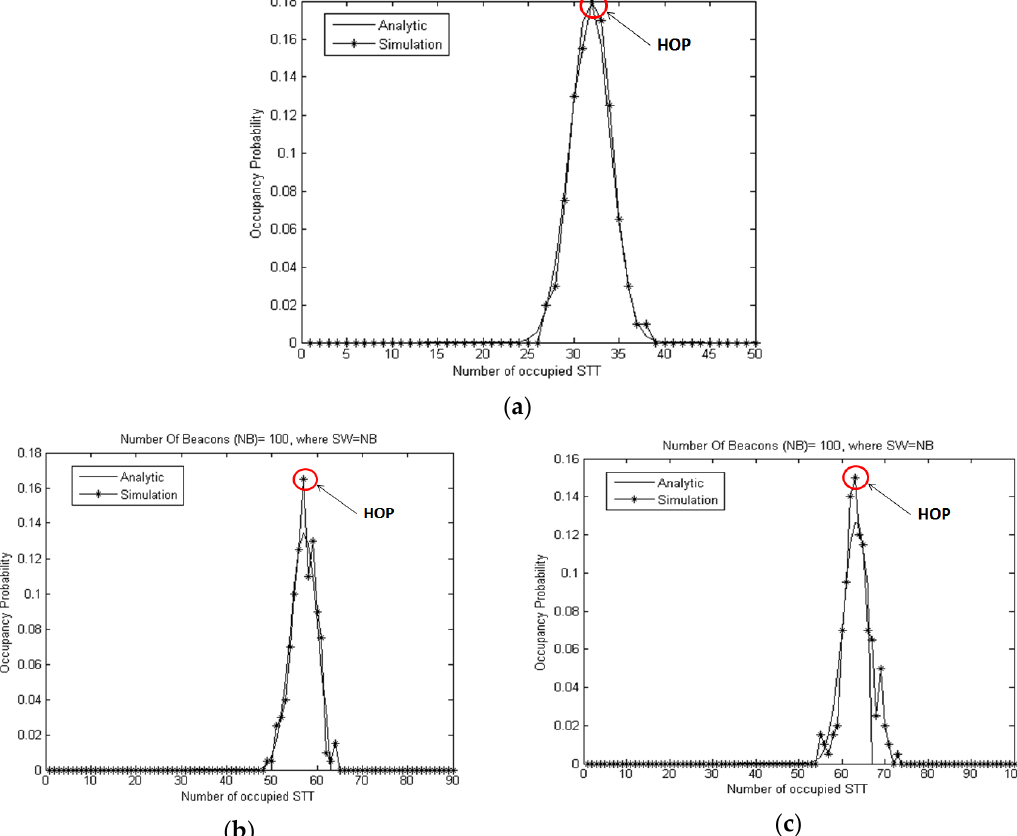
Figure 6. Comparison between analytical and simulation results of the occupancy probability for a different number of beacons, and where SW =